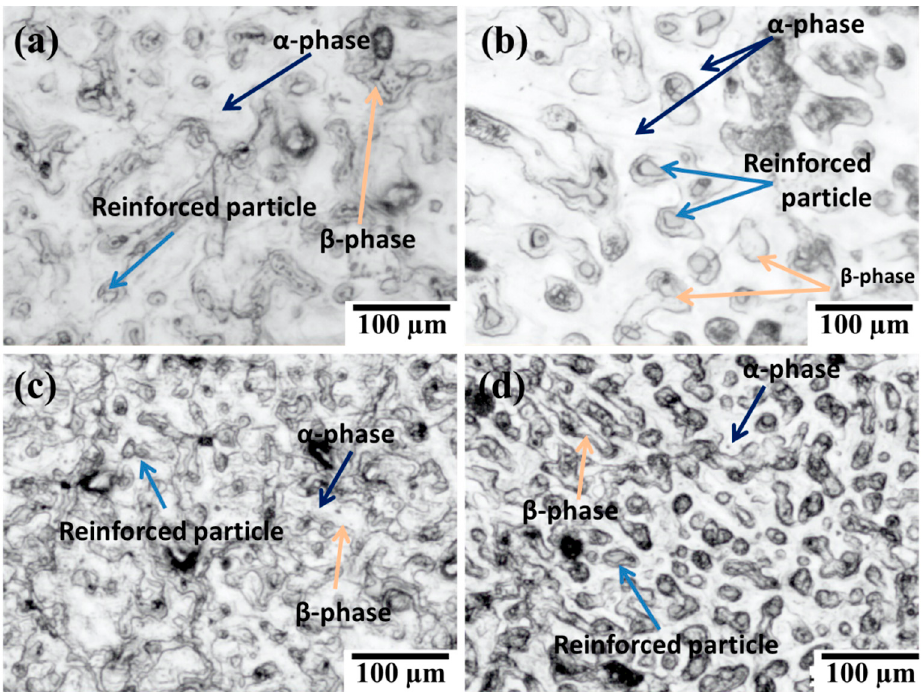
Figure 6. Optical micrographs for composites reinforced with SiC at ( a ) 3%; ( b ) 6%; ( c ) 9%; ( d ) 12%.